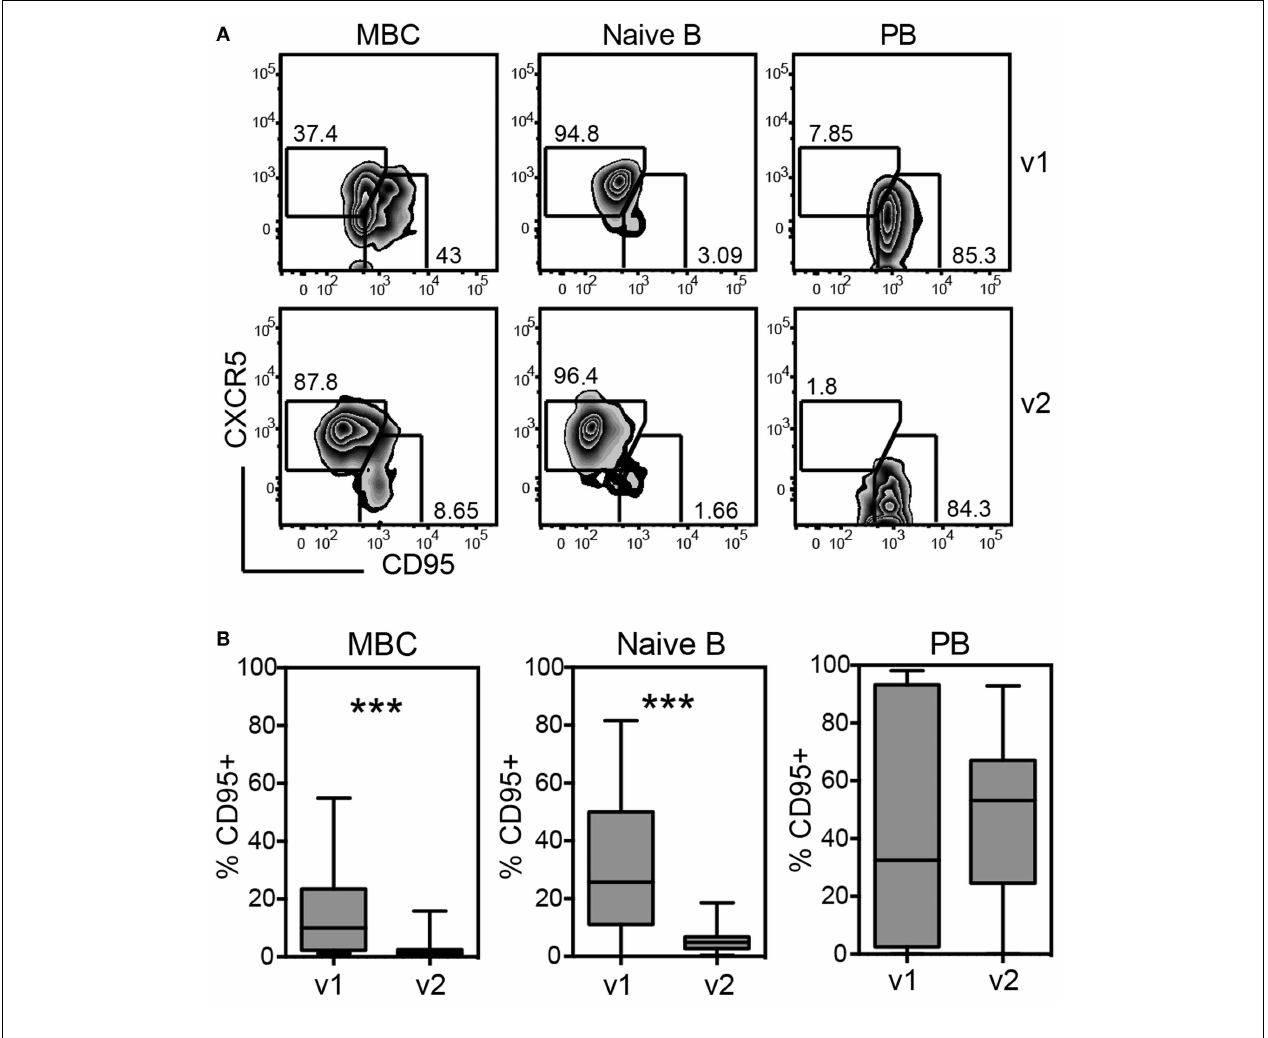
patients of cohort 2 regardless of primary or secondary infection. (A) Gating of CXCR5 and CD95-expressing cells during v1 and v2 for one representative patient. (B) Quantification of the percentages of CD95 + cells gated as illustrated in (A) . *** p < 0.001 (Wilcoxon matched-pairs signed rank